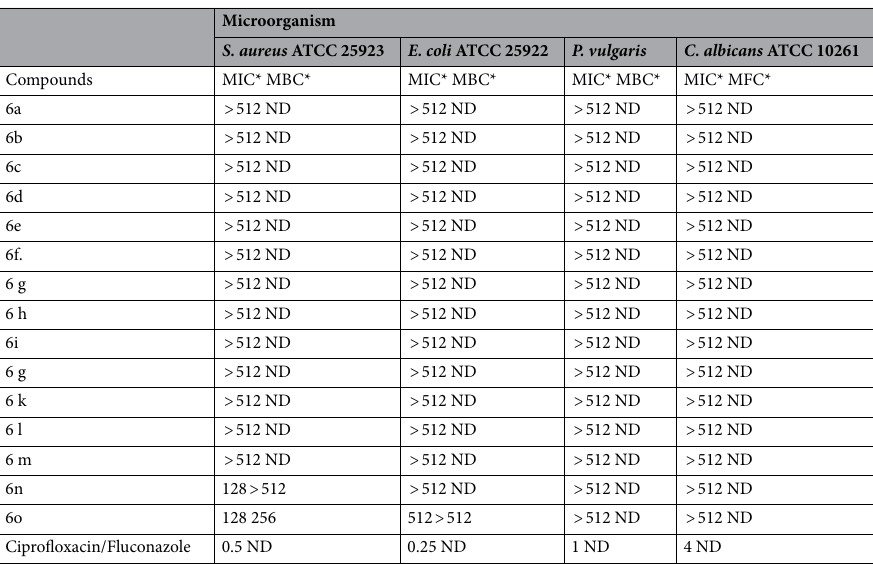
Table 3. Antimicrobial activity of thioxothiazolidinyl-acetamide compounds (6a–o). * MIC Minimum Inhibitory Concentration, MBC/MFC Minimum Bactericidal/Fungicidal, MICs and MBCs are expressed as µg/ ml.